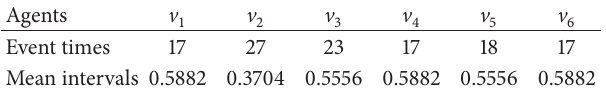
Table 1: Mean event intervals for the agents during 𝑡 ∈ [0,10] in Example 1.